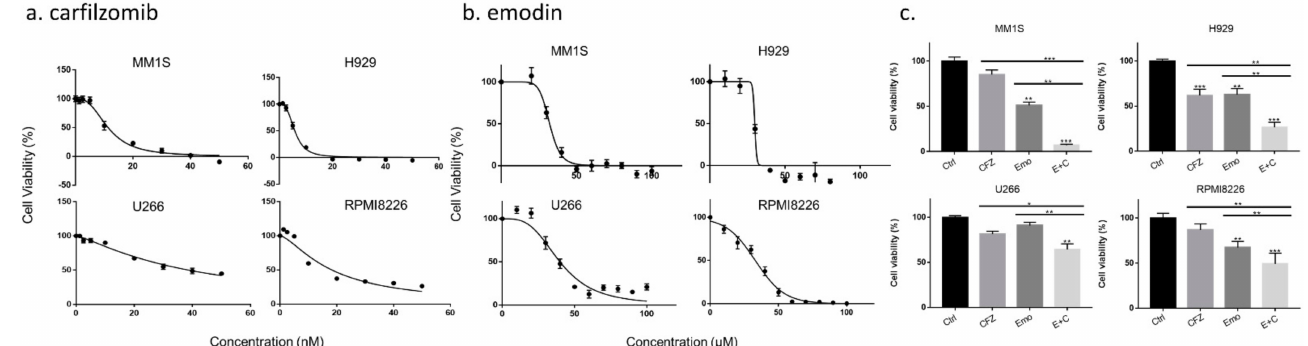
Figure 2. Cell viability of emodin (Emo), carfilzomib (CFZ), and combination drug of emodin and carfilzomib (E + C). ( a ) MM1S, H929, U266, and RPMI8226 cells were treated with various concentrations of CFZ for 72 h. ( b ) MM cells were treated with different emo concentrations for 72 h. ( c ) Emo (30 µ M) enhanced the CFZ (5 nM) induced cytotoxicity to MM cells. * p < 0.05; ** p < 0.01; *** p < 0.001.